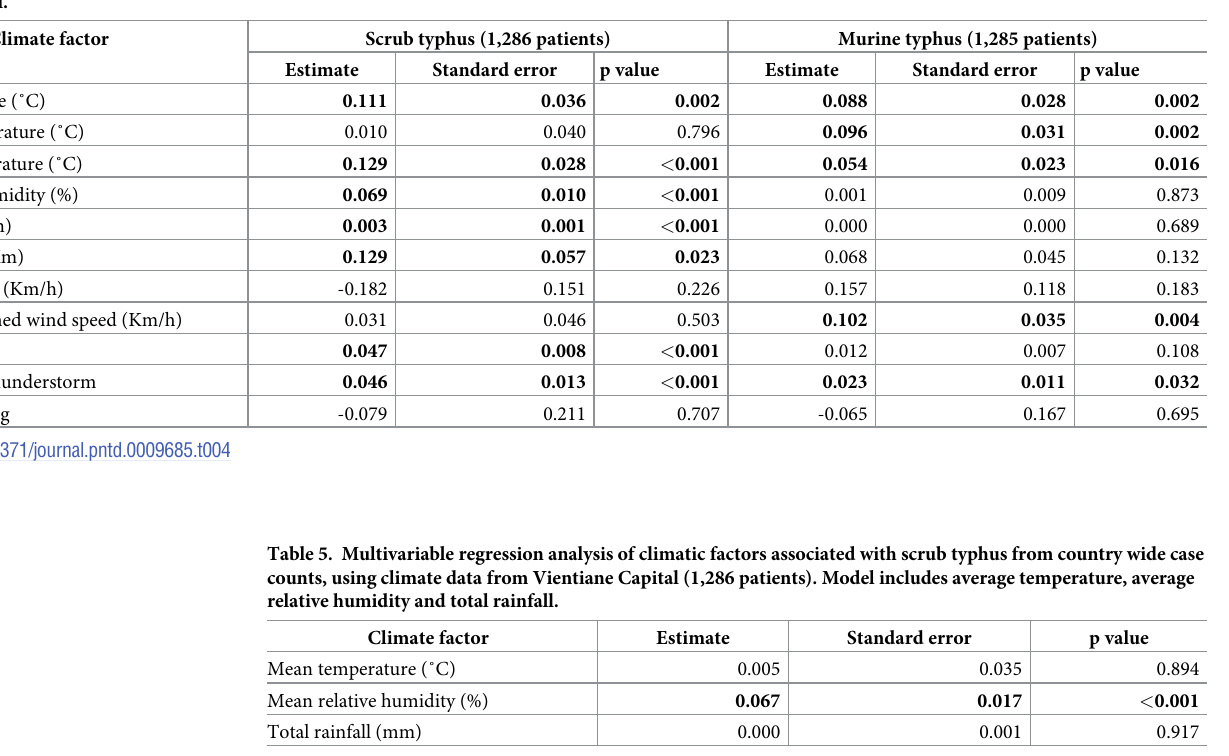
Table 4. Univariable regression analysis of climatic factors associated with scrub typhus and murine typhus from country wide case counts using climate data from Vientiane Capital.